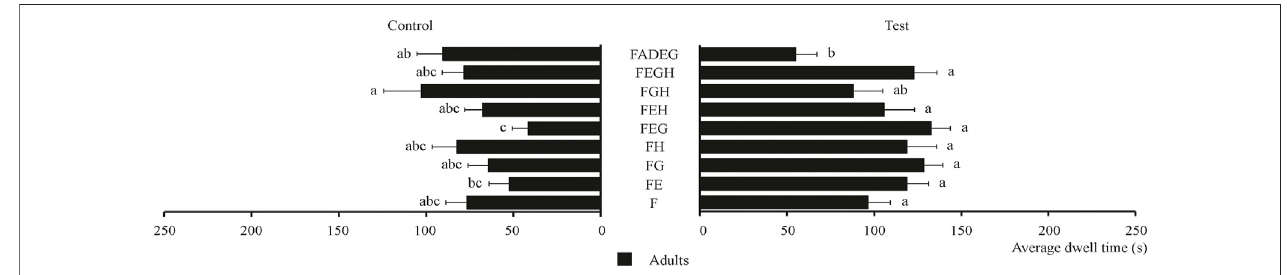
FIGURE 6 | Average dwell time of tobacco beetle adults in the combination of plant essential oils and food attractants. Different lowercase letters in the fi gure represent the average dwell time of tobacco beetle adults with a signi fi cant difference at p < 0.05 in different combinations. Error bars shown in the fi gure represent mean ± SE.